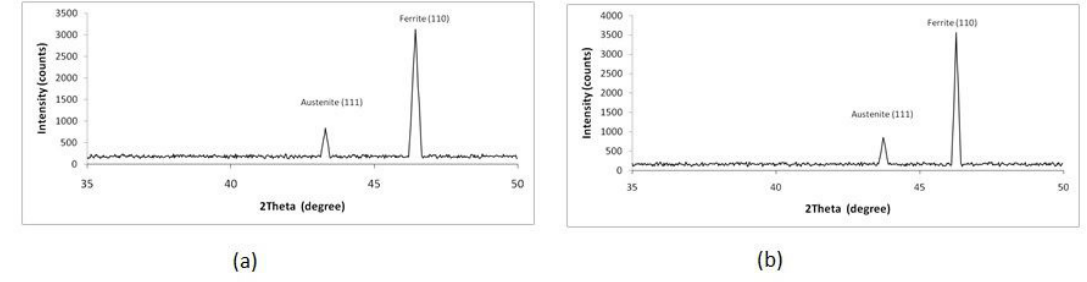
Figure 7. XRD graphs for ADI samples austenitized at 850ºC and austempered at 320ºC with (a) 0.268 wt% Mn, (b) 1.01 wt% Mn.